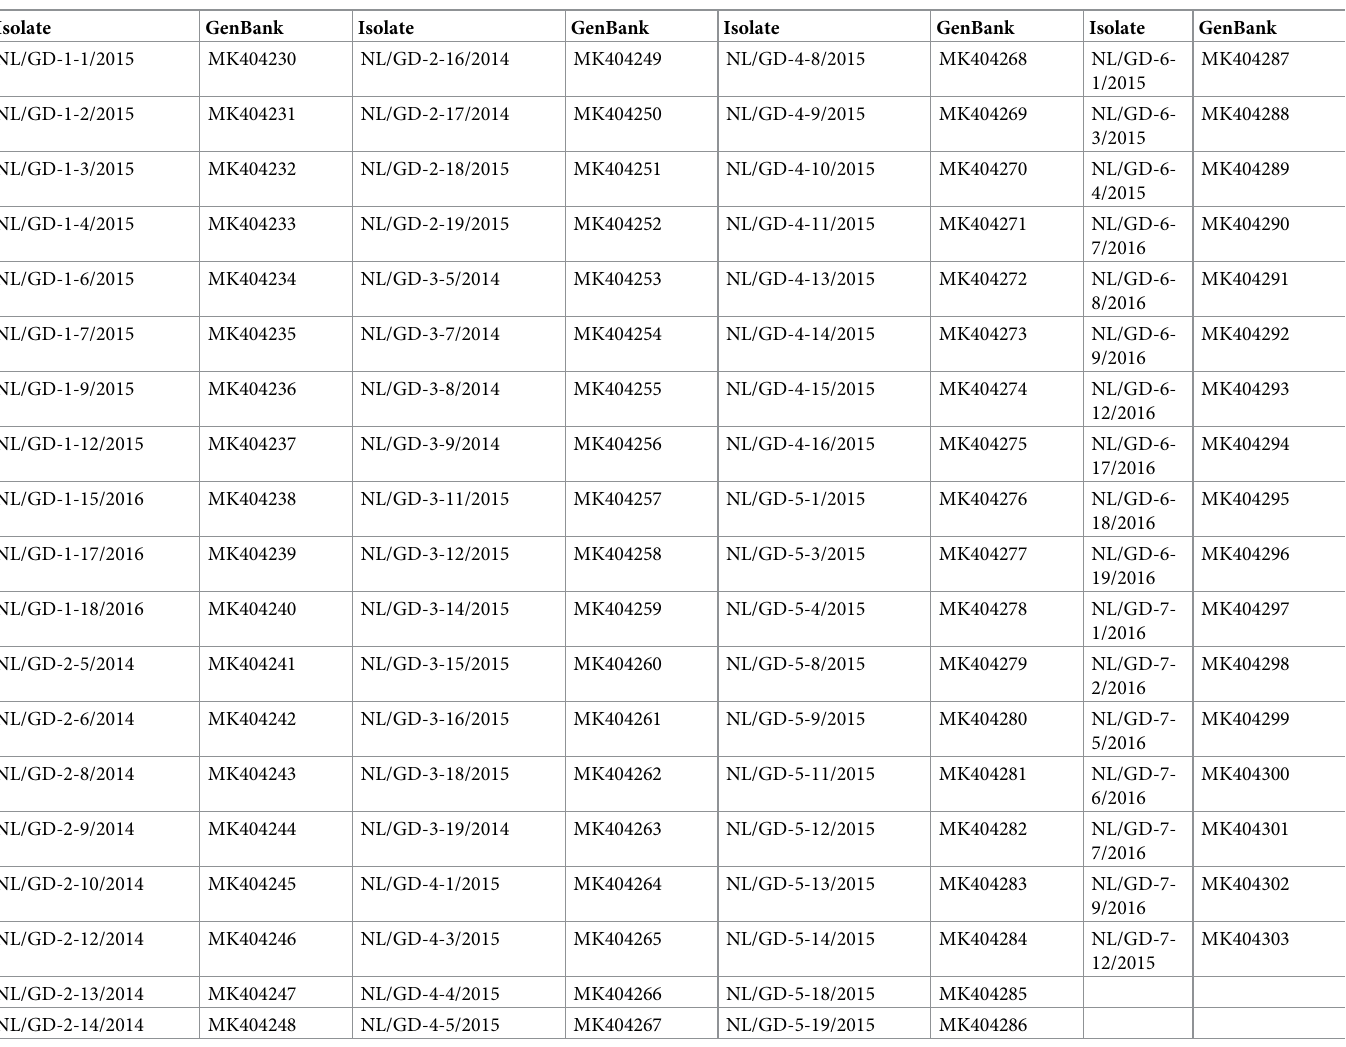
Table 1. GenBank accession numbers of 74 Dutch PRRSV